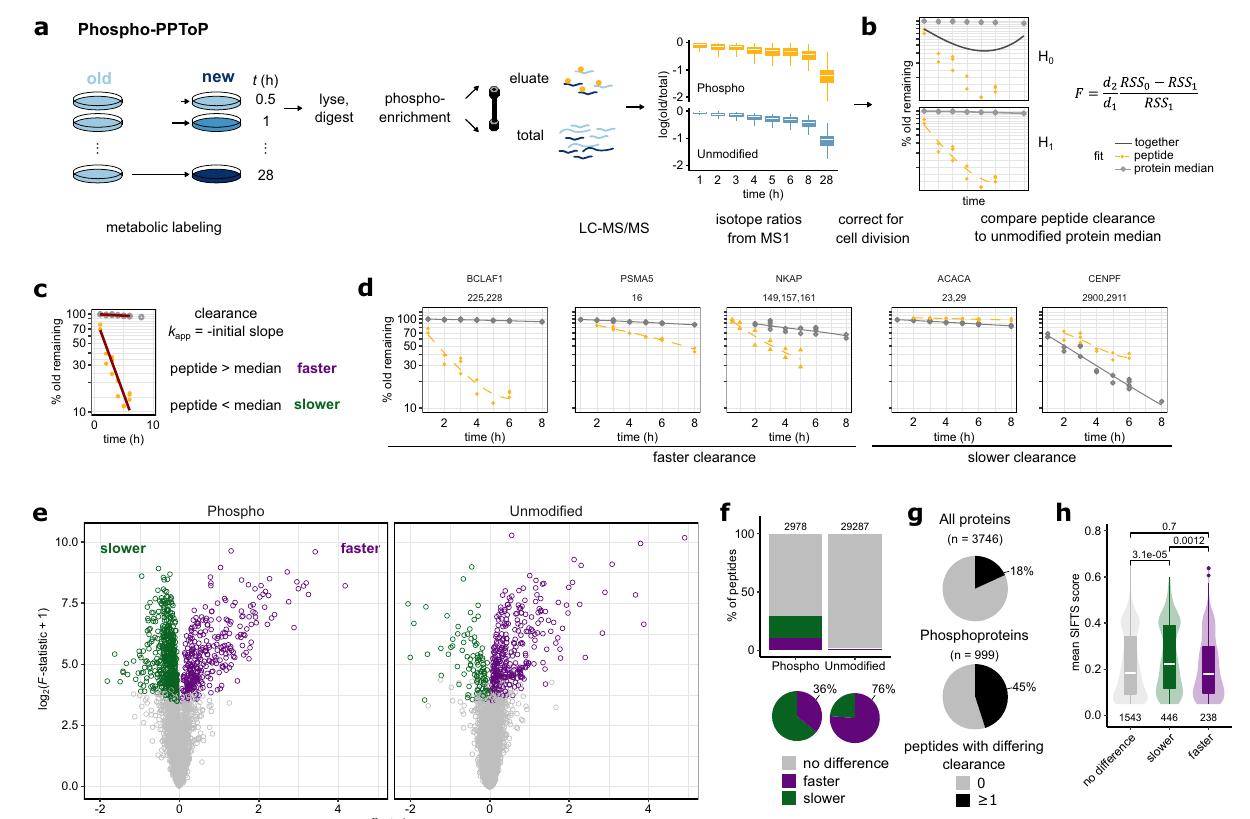
Fig. 2 | Measuring peptide clearance with PPToP. a Experimental setup. HeLa cellsweregrowninisotopicallylight(L)-labeledmediumand pulsed foraspeci fi ed timewithheavy(H)-labeledmedium(Replicates1 – 3;LandHreversedforReplicate 4). After lysisand trypsin-digest, phosphorylated peptideswereenriched using Fe- IMAC. Both the eluate enriched for phosphorylated peptides (phospho, in yellow) as well as the fl ow-through (unmodi fi ed, in blue) were measured with mass spec- trometry. Boxplots show replacement of old with new labeled protein over time, y axis:medianvaluesoverreplicatesontheproteinlevel.Outliershavebeenomitted for clarity. b After correction for cell growth (see “ Methods ” ), clearance traces for each peptide are compared to the trace of the median of all unmodi fi ed peptides (representingtheentireproteinpool P )to fi nd peptideswithsigni fi cantlydifferent clearance. See “ Methods ” for details. c Fitting ofthe initialslopeto assignpeptides tofasterorslowerclearance. d Exampletracesofphosphopeptides(yellow)whose clearance signi fi cantly deviates from the protein median (gray). Numbers over